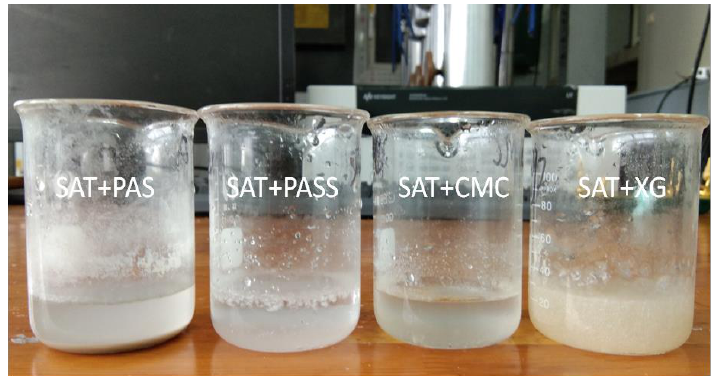
Figure 6. Thickening effect of different thickeners on SAT samples.